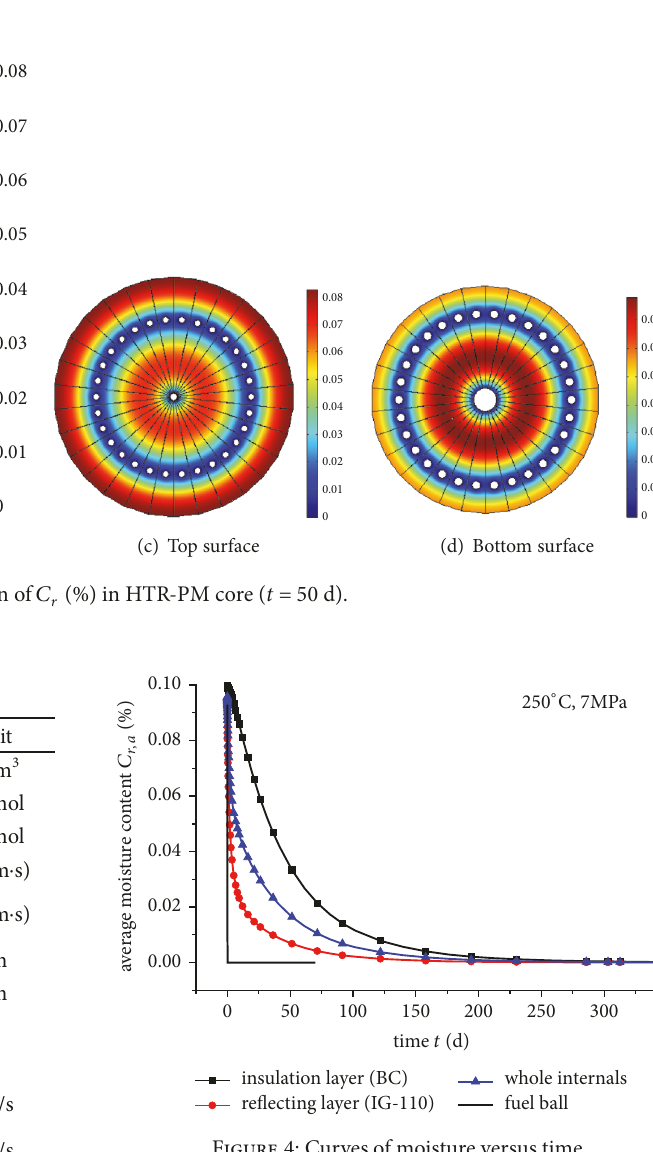
Figure 4: Curves of moisture versus